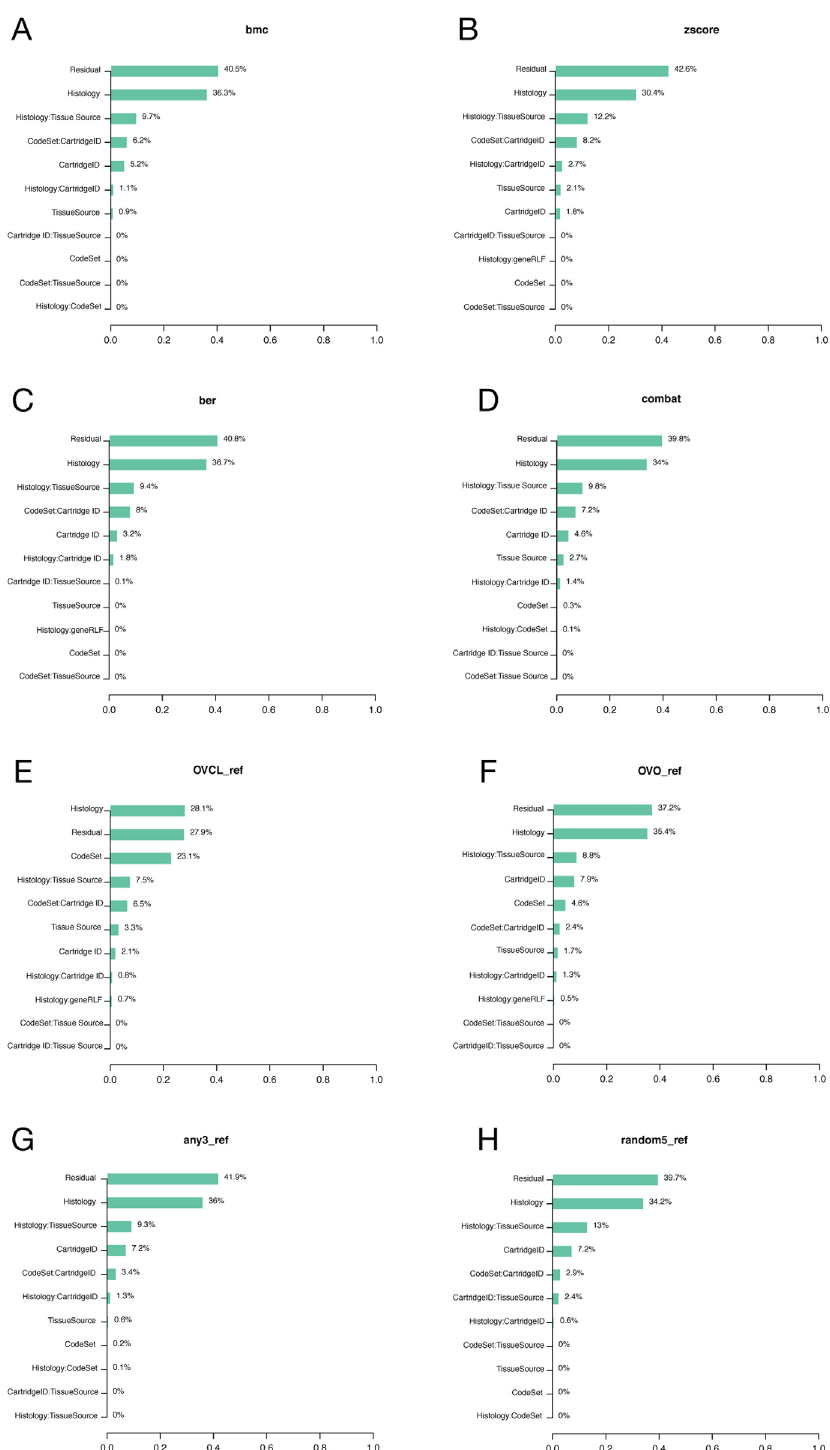
Fig 6. PVCA of the OC clinical samples after adjusting batch effect using different methods. We consider the PVCA plot of the OC clinical samples run in different batches after adjusting BE with different methods. In each plot, percentages represent the variability explained by each factor and first order interaction between